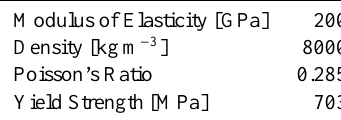
Table 2. Stainless steel material